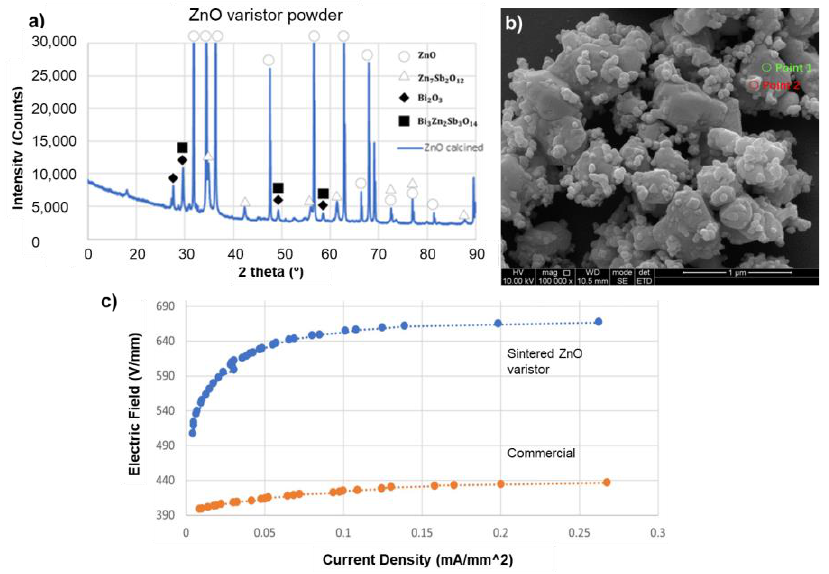
Figure 3. ( a ) XRD spectra of the synthesized powders containing ZnO and oxide additives; ( b ) SEM image of the synthesized powder showing a submicron ZnO particle decorated with nano-sized additive particles; ( c ) I–V curves of the sintered ceramics made of ZnO varistor calcined at 750 ◦ C and a commercial metal oxide